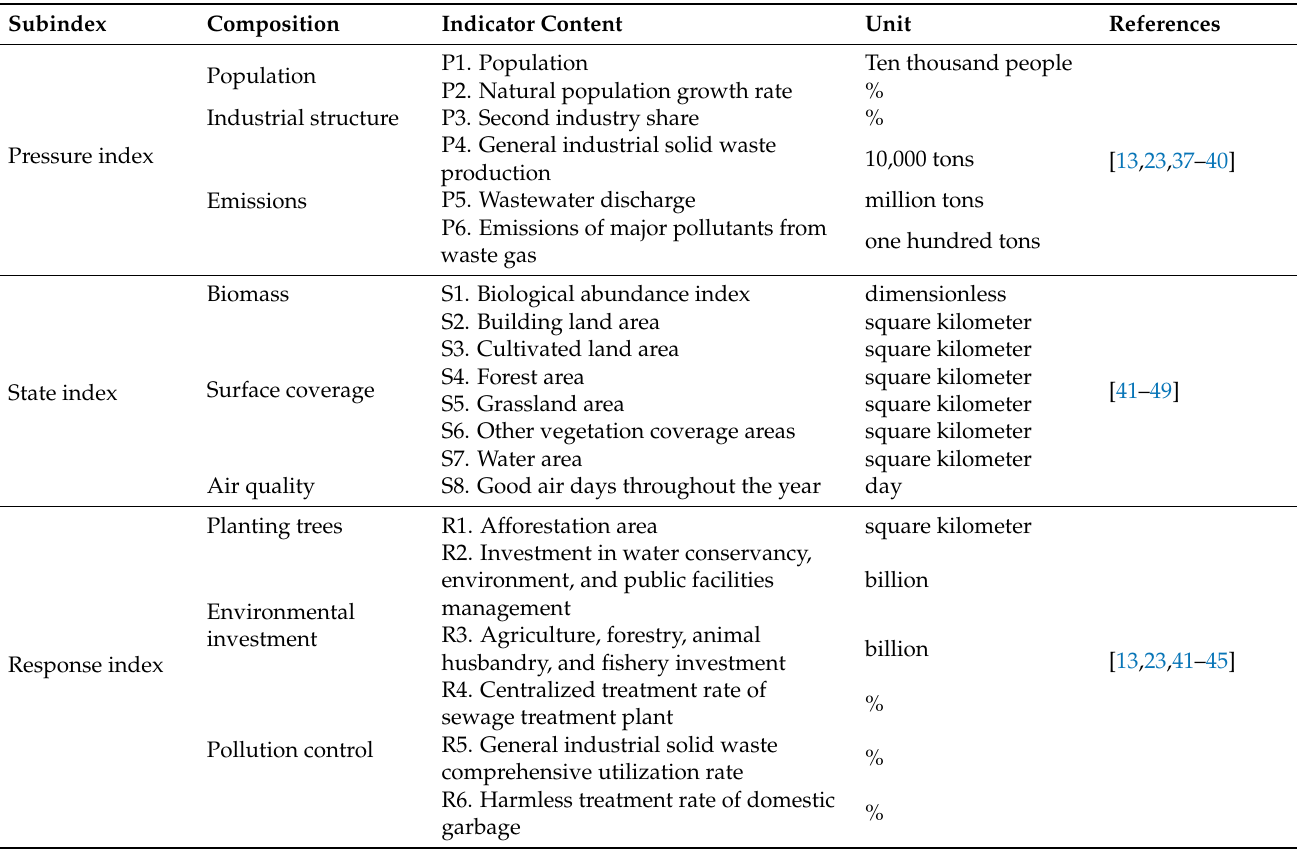
Table 2. Indices included in the proposed UGEI